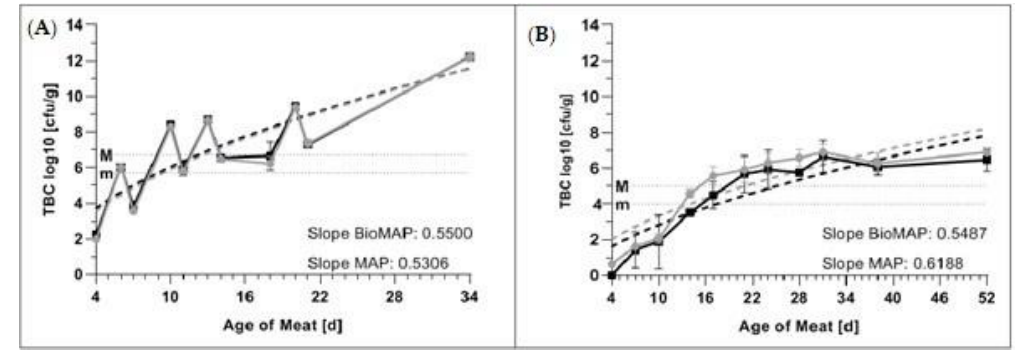
Figure A2. Average TBCs (±S.D.) in BioMAP and MAP in ( A ) ground pork (GM) and ( B ) pork loin (PL) over a meat age of 34 and 52 days, respectively. Microbiological limits “m” and “M” as per European Union legislation are indicated for both meat matrices. The fitted curves are indicated by dotted lines for GM and PL in BioMAP and MAP, respectively, with slope values included in the graphs.